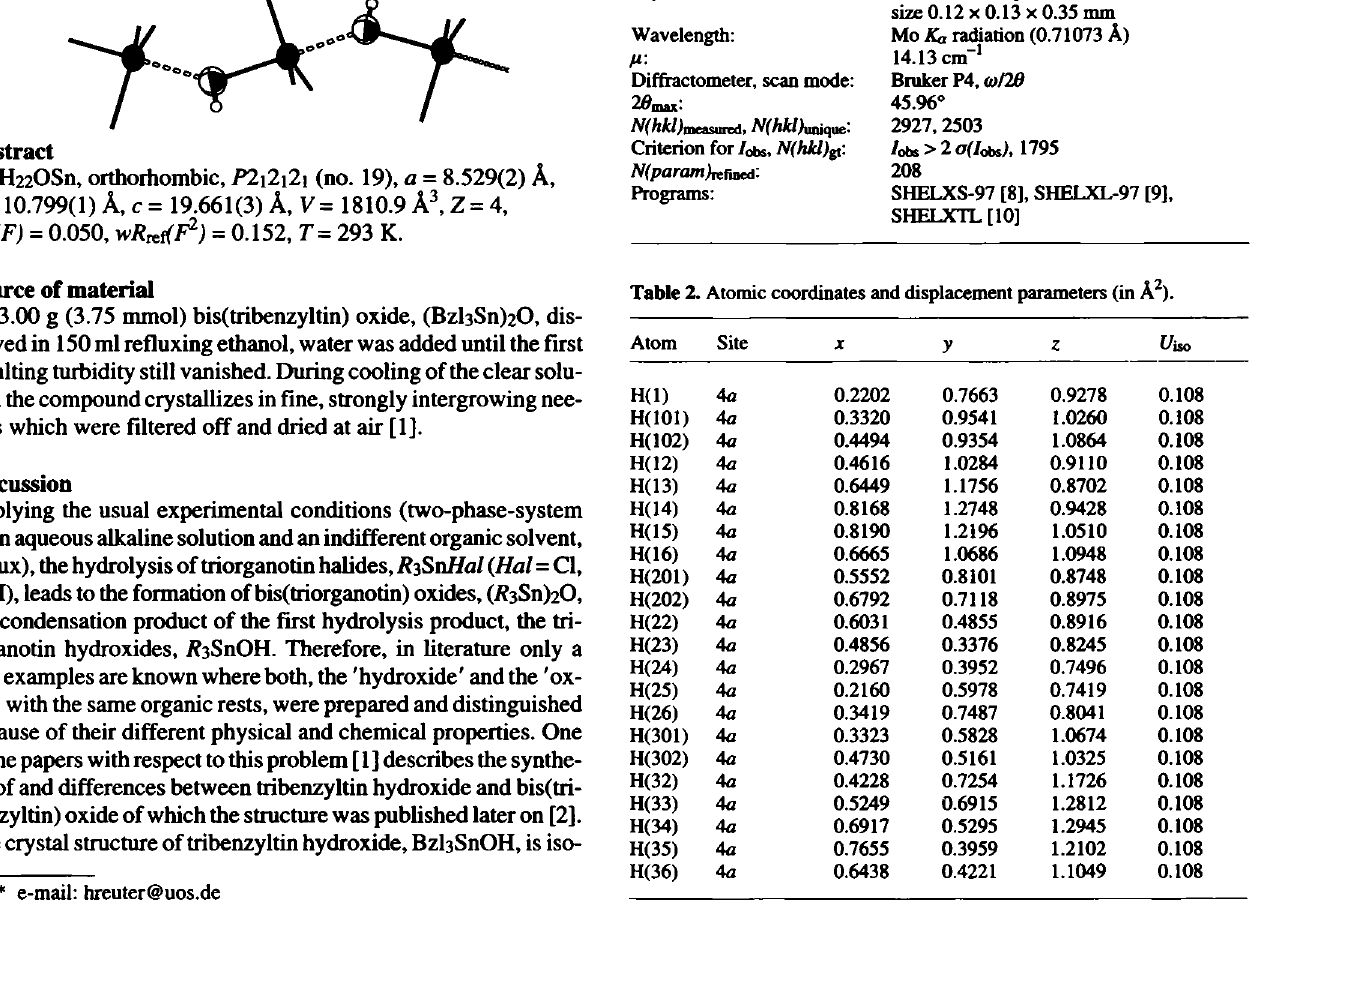
Table 1. Data collection and handling. Crystal: